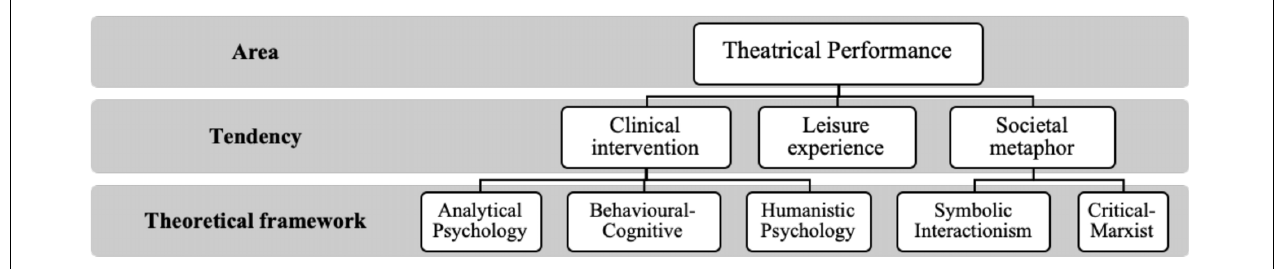
The modality of psychoanalysis